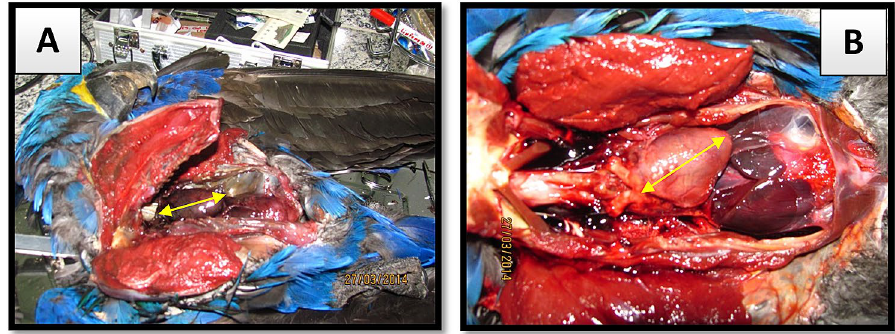
Figure 2. Differences in visceral coloration of two individuals. Heart length: In [( A ) 2014-02 = 41.3 mm and in ( B ) 2014-03 = 41.6 mm]. Photo: Eliane Vicente.